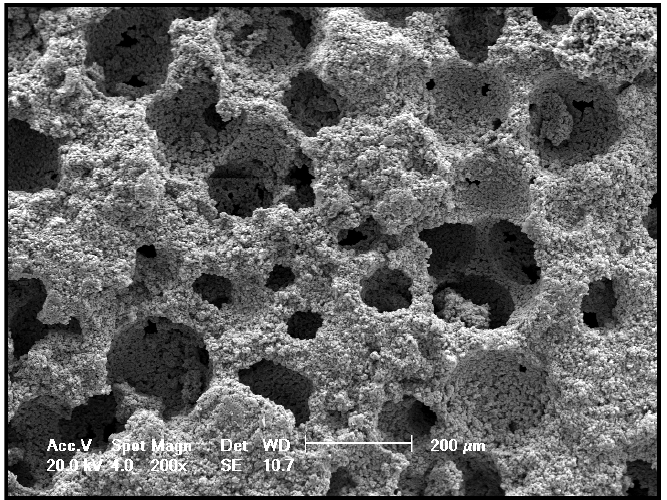
FIGURE 2 - Scanning electron micrography of the macroporous CPC surface. Magnification of 200x.